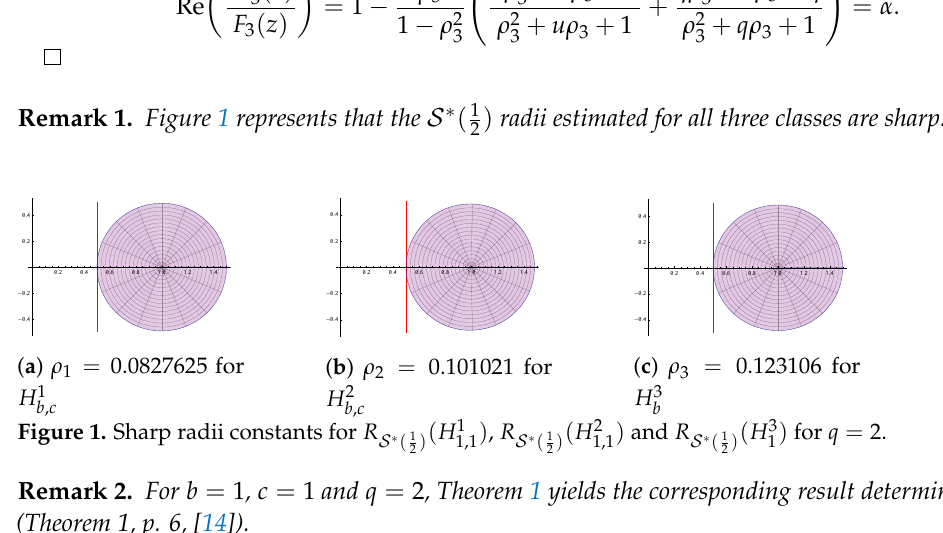
( H 3 ) for q = S ∗ ( 1 ) 1 2